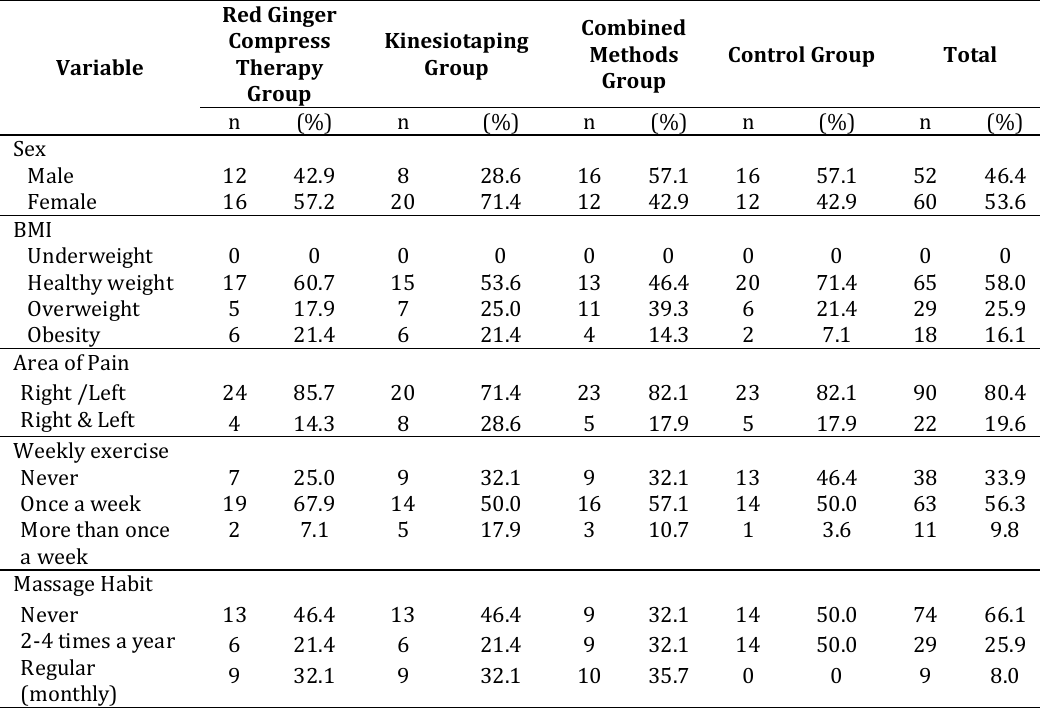
Characteristics of respondents: sex, BMI, area of pain, weekly exercise, massage habit